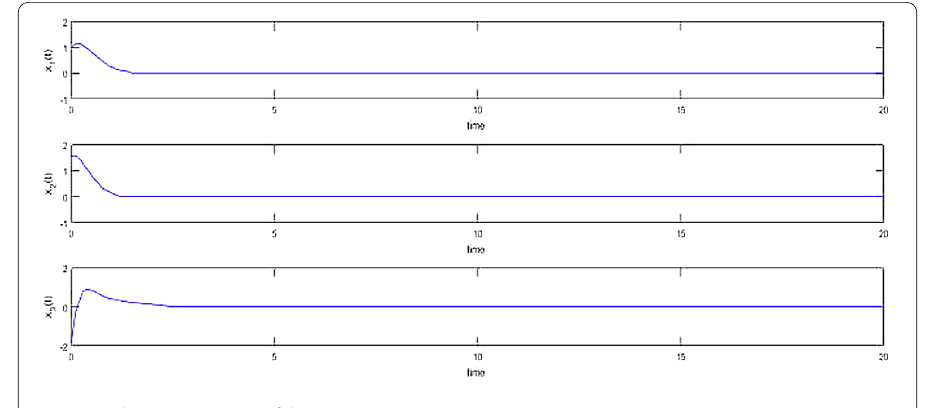
Figure 1 The time response of the system in paper